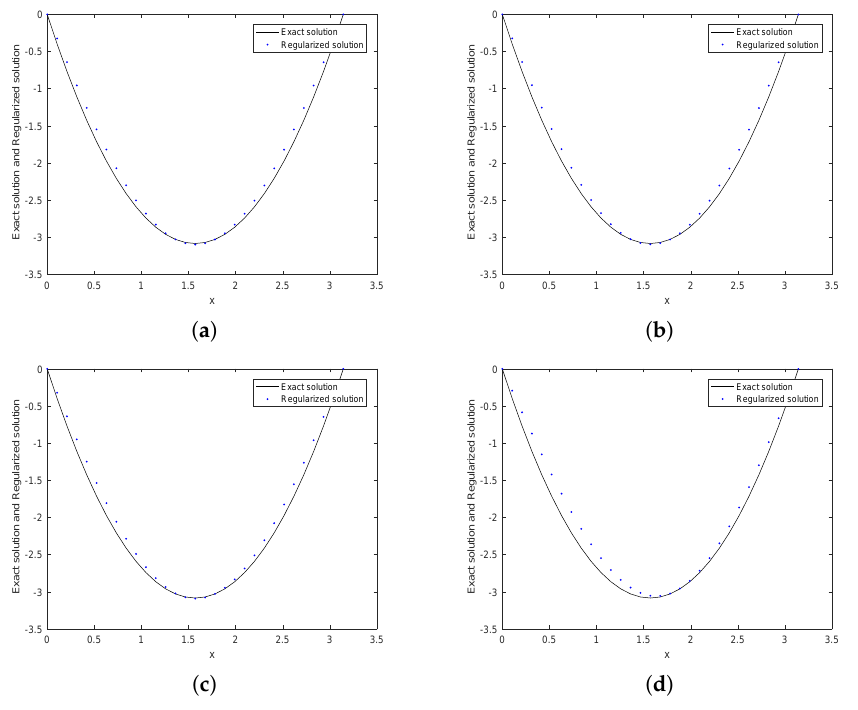
Figure 1. k = 0.5, γ = 2, q = 4; Exact and Regularized solutions for various ε . ( a ): ε = 0.001, ( b ): ε = 0.01, ( c ): ε = 0.05, ( d ): ε = 0.1.